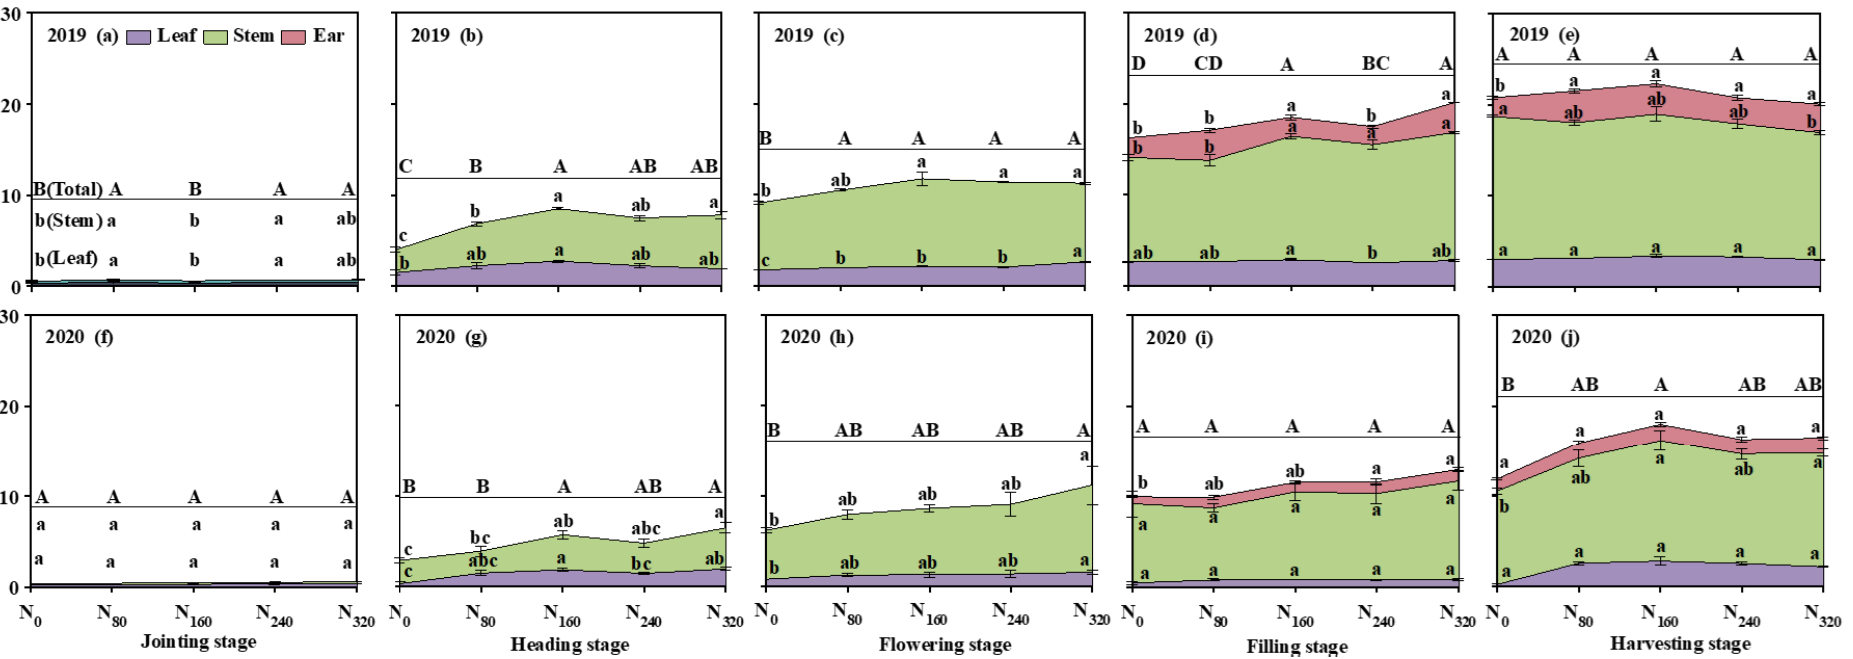
Figure 3. Dynamics of dry matter accumulation of leaf, stem, and ear in forage sorghum under different N application rates in 2019 (a − e) and 2020 (f − j). The different lowercase letters in the same parts (leaf, stem, and ear) represent significant difference at p < 0.05 among the different N treatments. Different capital letters represent significant differences at p < 0.05 in the total above − ground parts of dry matter accumulation among the different N treatments.